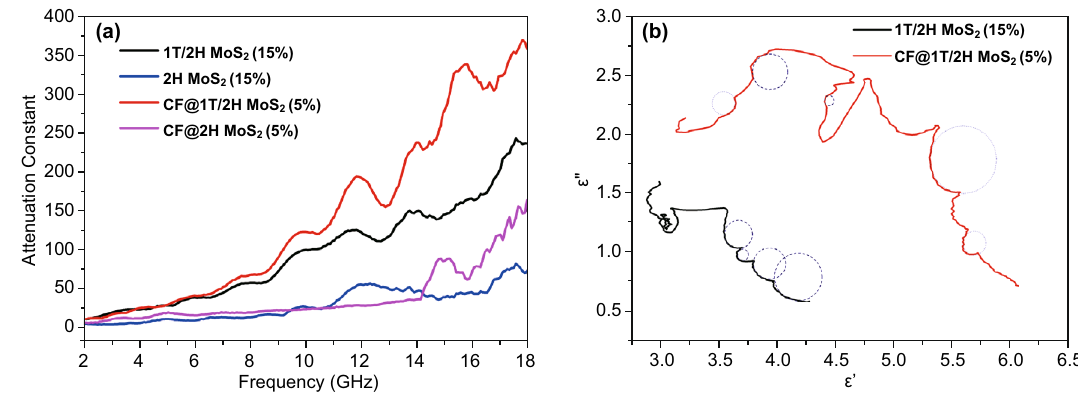
Fig. 7 a Attenuation constant of 1T/2H MoS 2 and 2H MoS 2 (15%), CF@1T/2H MoS 2 and CF@2H MoS 2 (5%). b Cole–Cole semicircle of 1T/2H